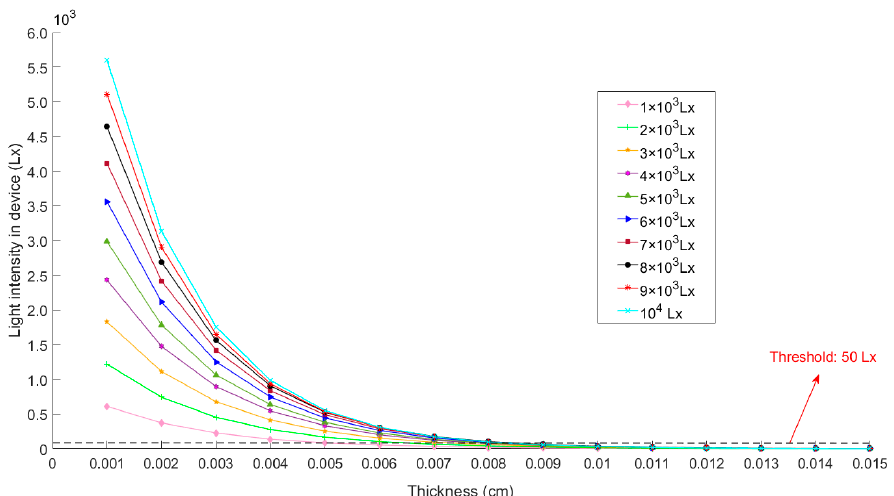
Figure 6. The variation of the light intensity value in the test box with the thickness of the ink under different light intensities.